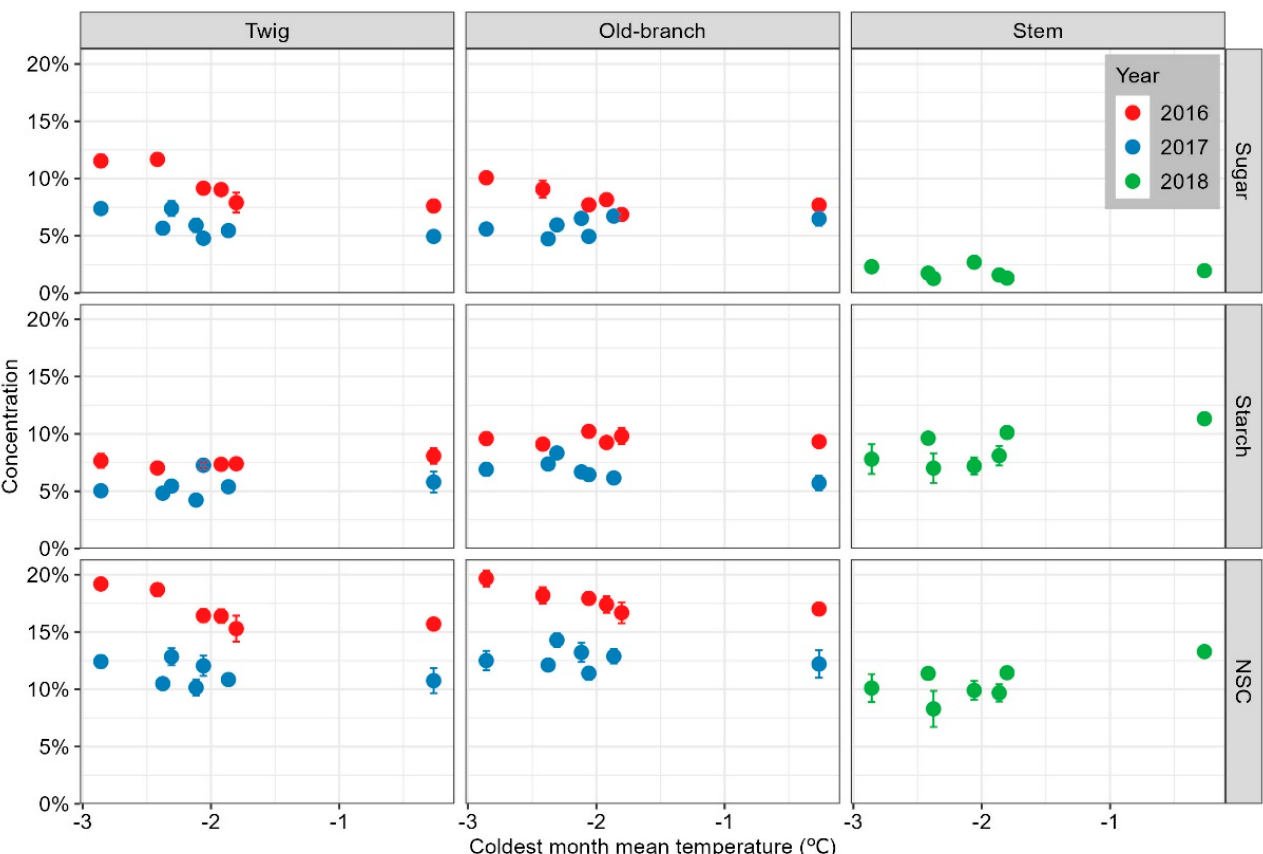
Figure 3. Variations in NSC concentration, soluble sugar, and starch in twigs, old branches, and trunks of Cyclobalanopsis gracilis adults in autumn along the temperature gradients. The results are shown as the mean ± standard error. The mean value of each point is the average of 3–5 replications (5 replications for the twig and old branch; 3 replications for the stem). All relationships were non-significant ( p > 0.05).